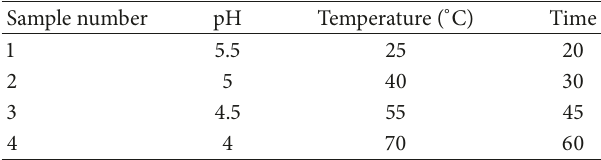
Table 1: Different parameters combinations used to dye